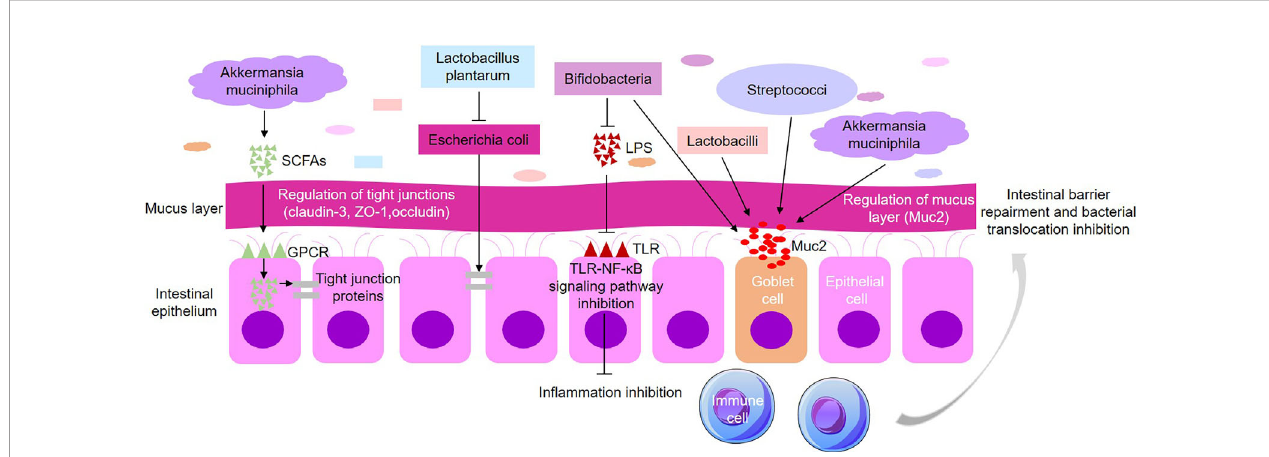
FIGURE 2 | Gut microbiota affects the function of intestinal epithelial barrier. Different types of microbiota act on various targets associated with intestinal epithelial barrier. Bif fi dobactrium , Lactobacilli , Streptococci and Akkermansia muciniphila stimulate the secretion of MUC2. SCFAs produced by Akkermansia muciniphila enter into the intestinal epithelial cells through GPCR to increase the expression of tight junction protein claudin-3 and occludin. Lactobacillus plantarum inhibits pathogenic Escherichia coli growth and increases the expression of ZO-1 and occludin. Bif fi dobactrium diminishes the formation of LPS and inhibits the TLR-NF- k B signaling to alleviate in fl ammation, hence decreasing intestinal permeability and bacterial